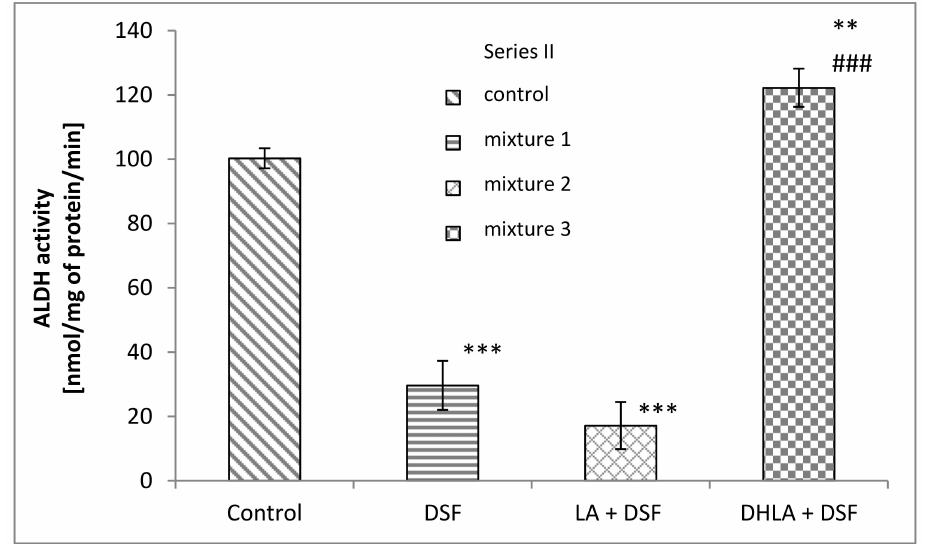
Figure 5. The e ff ect of DSF on the activity of rat liver-derived ALDH preincubated with 1 mM LA / DHLA. Only DHLA was able to protect ALDH activity blocked by DSF. The experiment was performed in triplicate. Data are shown as the mean ± SD. Significant vs. control sample: ** p < 0.01; *** p < 0.001. Significant vs. DSF sample: ### p < 0.001.